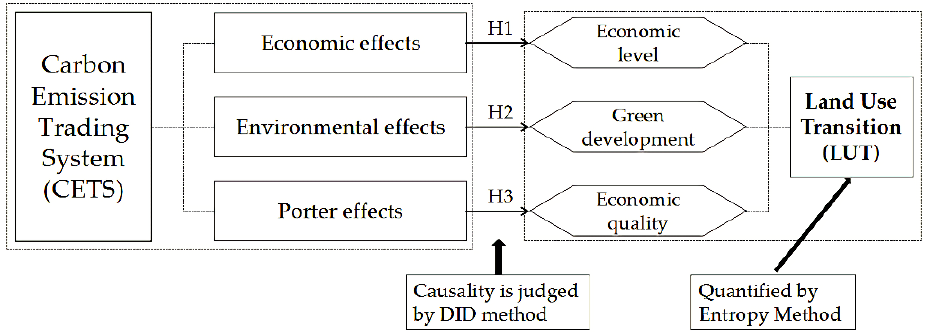
Figure 1. Technical path.